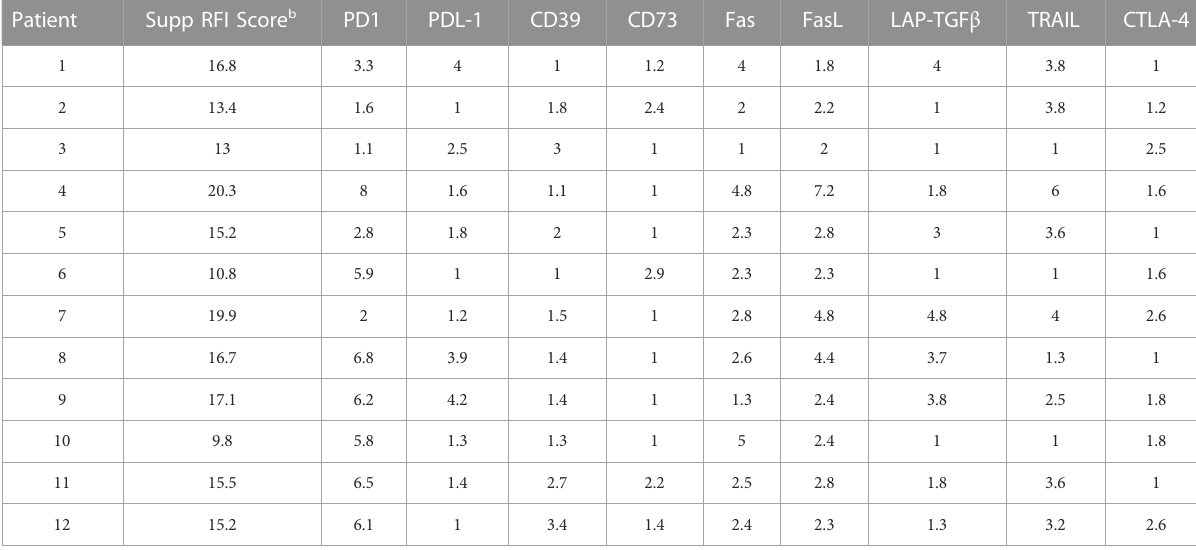
TABLE 1 Immunosuppressive proteins in MTEX a .